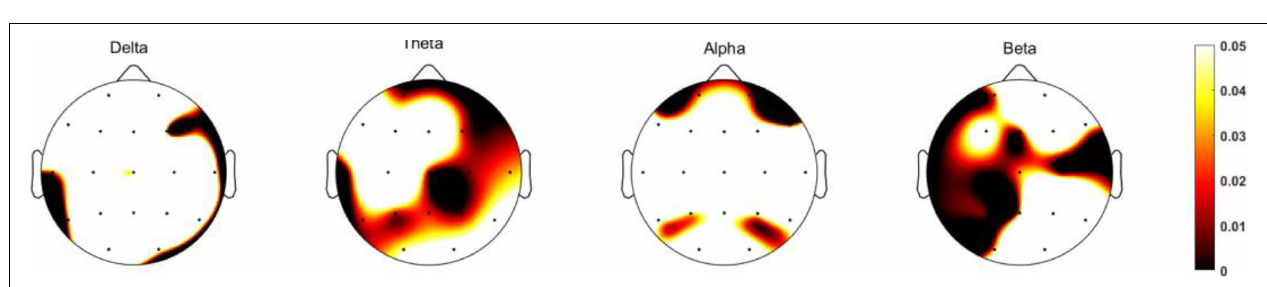
FIGURE 5 | Average power spectral density (PSD) vs. frequency values of all channels. Upper panel displays liked case and lower panel shows disliked cases.